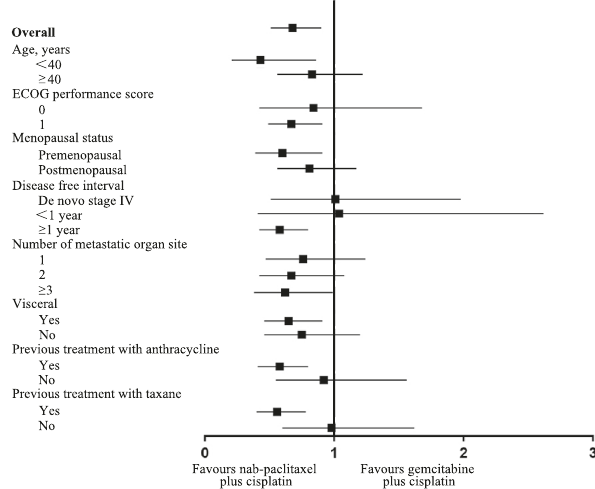
Fig. 3 Subgroup analysis of PFS. Data are median for ITT population in clinically relevant subgroups. Subgroup included patients with <40 years ( n = 45) and ≥ 40 years ( n = 208); ECOG = 0 ( n = 40) and ECOG = 1 ( n = 213); premenopausal status ( n = 113) and postmenopausal status ( n = 140); de novo stage IV ( n = 48), disease-free survival <1 year ( n = 29) and ≥ 1 year ( n = 176); No. of metastatic organ site = 1 ( n = 94), = 2 ( n = 81) and ≥ 3 ( n = 78); visceral metastasis ( n = 163) and no visceral metastasis ( n = 90); previous treatment with anthracycline ( n = 173) and with no anthracycline ( n = 80); previous treatment with taxane ( n = 170) and with no taxane ( n = 83). HRs and corresponding 95% CIs were estimated using Cox-proportional-hazard regression model. Data are presented as HR and 95% CI. HR hazard ratio, ECOG Eastern Cooperative Oncology Group.